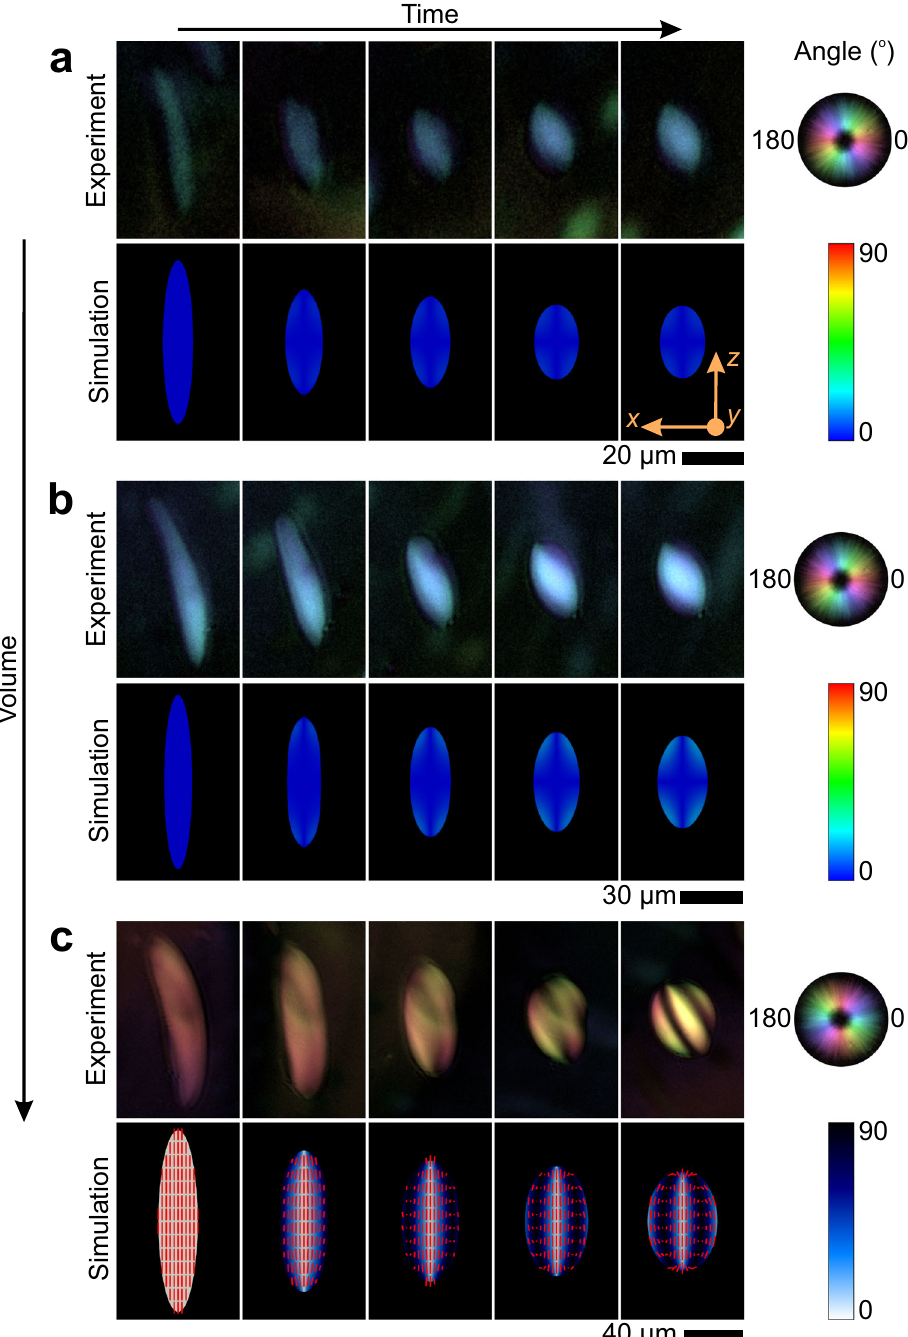
Fig. 1 Relaxation of different classes of the amyloid fi bril liquid crystalline droplets. The sequence of time-lapse images of relaxation of initially extended amyloid fi brils liquid crystalline droplets with different volumes. In each panel, the fi rst row shows the experimental results taken with LC (liquid crystal)- PolScope device. The colormaps corresponding to experimental results denote the orientation of the director fi led in the x – z plane; the second row demonstrates the numerical simulation results with color bar capturing the director fi eld orientation with respect to z -axis. The tactoids are at the homogenous con fi guration at the initial state and upon relaxation, they hold different con fi gurations. a An initially extended tactoid with volume 644 µ m 3 undergoes shape relaxation while its con fi guration remains unchanged at homogenous con fi guration. b An elongated tactoid with volume 2751 µ m 3 relaxes both its shape and structure recovering a bipolar con fi guration upon relaxation. c A droplet with volume 16,414 µ m 3 , having larger volume compared to ( a , b ), relaxes to a cholesteric structure with three bands. Since colors and director lines show the same information due to the axisymmetric nature of the homogenous ( a ) and bipolar ( b ) tactoids, the lines are not shown for better readability (see Supplementary Movies 4 – 6 for the version with lines). Note that the brightness of the experimental images is varied for better